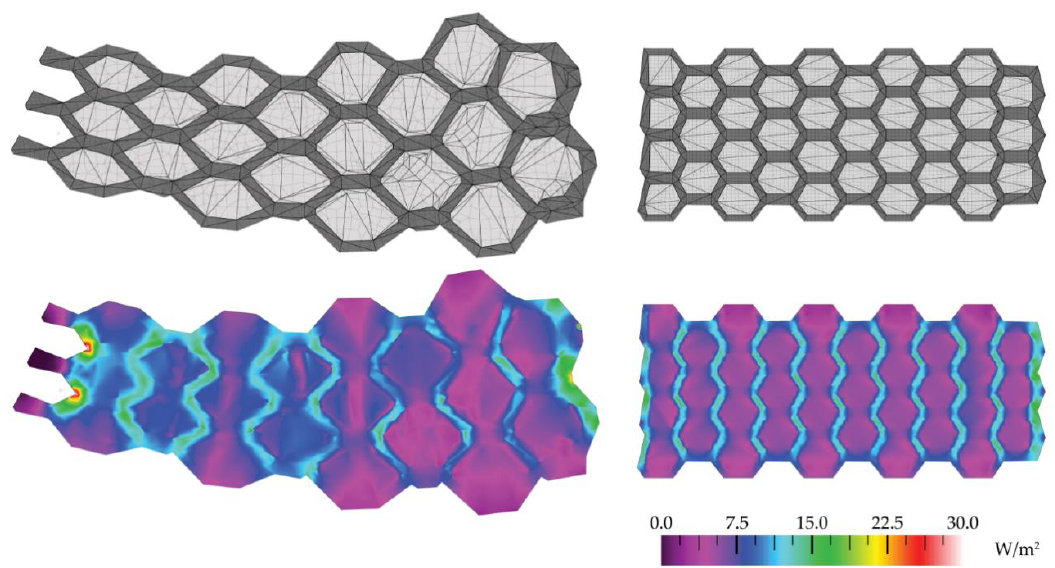
Figure 10. Results of the 2D simulations showing the finite element mesh ( top ) and the calculated heat flux visualized by a colored flux magnitude ( bottom ) for one respective layer of the existing prototype ( left ) and the optimized geometry ( right ).